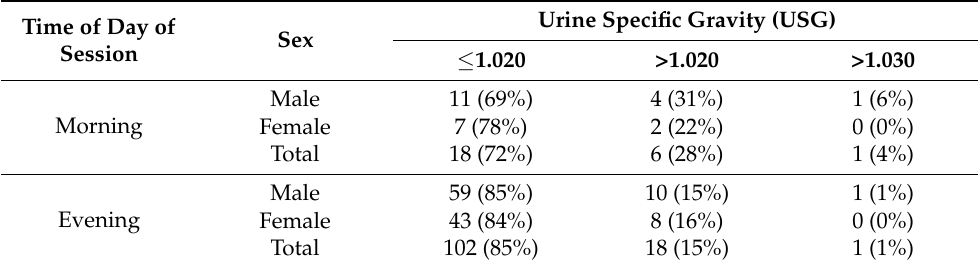
Table 3. Level of dehydration between sexes (male vs. female) and time of day of running session (morning vs. evening) based on pre-exercise urine specific gravity